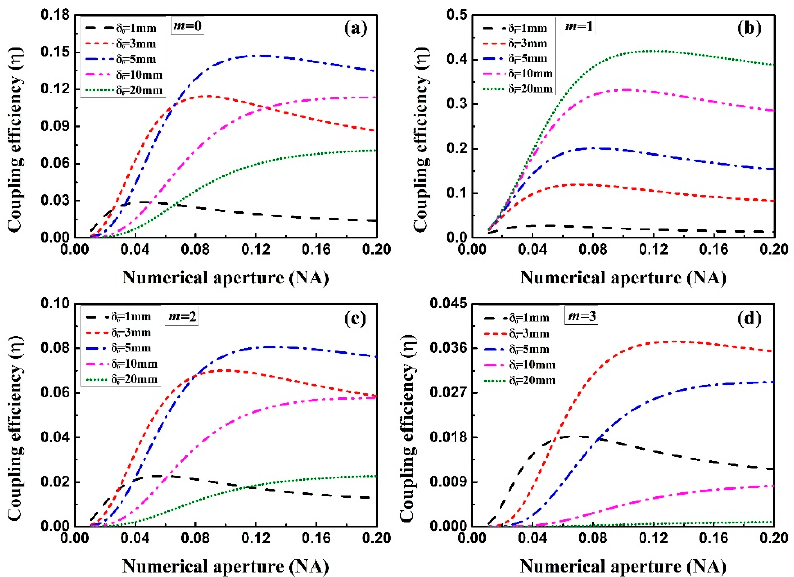
Figure 3. The coupling efficiency of the symmetric beam with ω 0 = 10 mm and λ = 1550 nm varied with NA for different values of δ 0 under different topological charges.